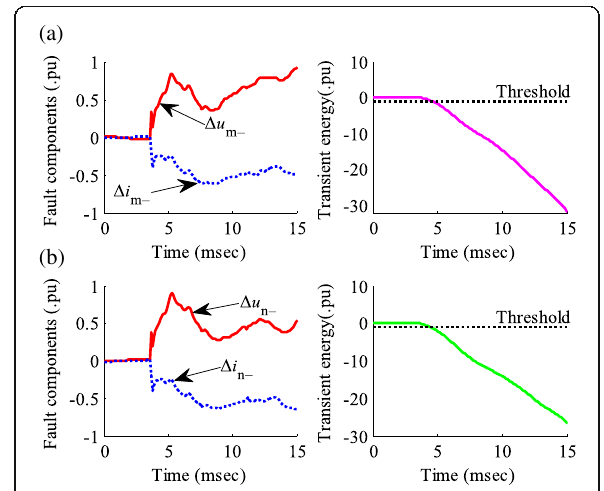
Fig. 7 Waveforms of fault components and transient energies detected on the positive pole line for a fault at F 1. a Rectifier station.